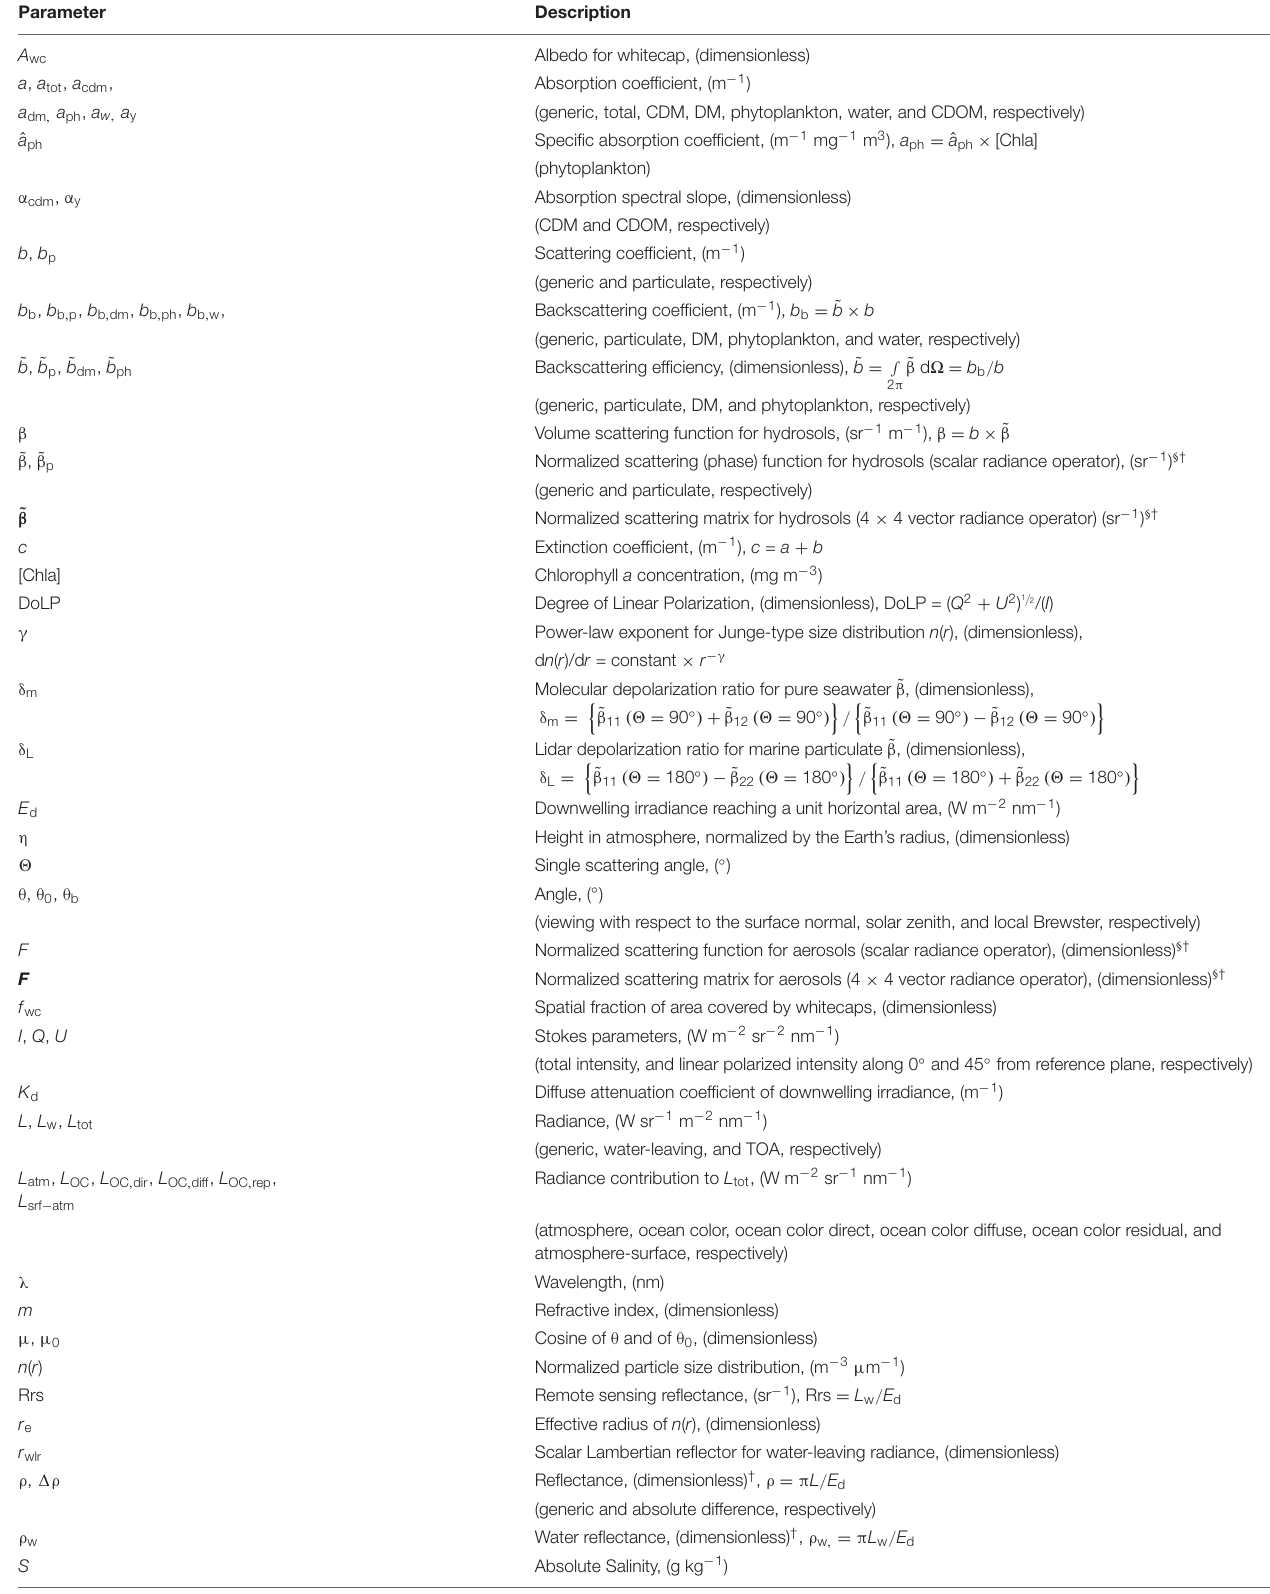
TABLE 2 | List of parameters. Parameter